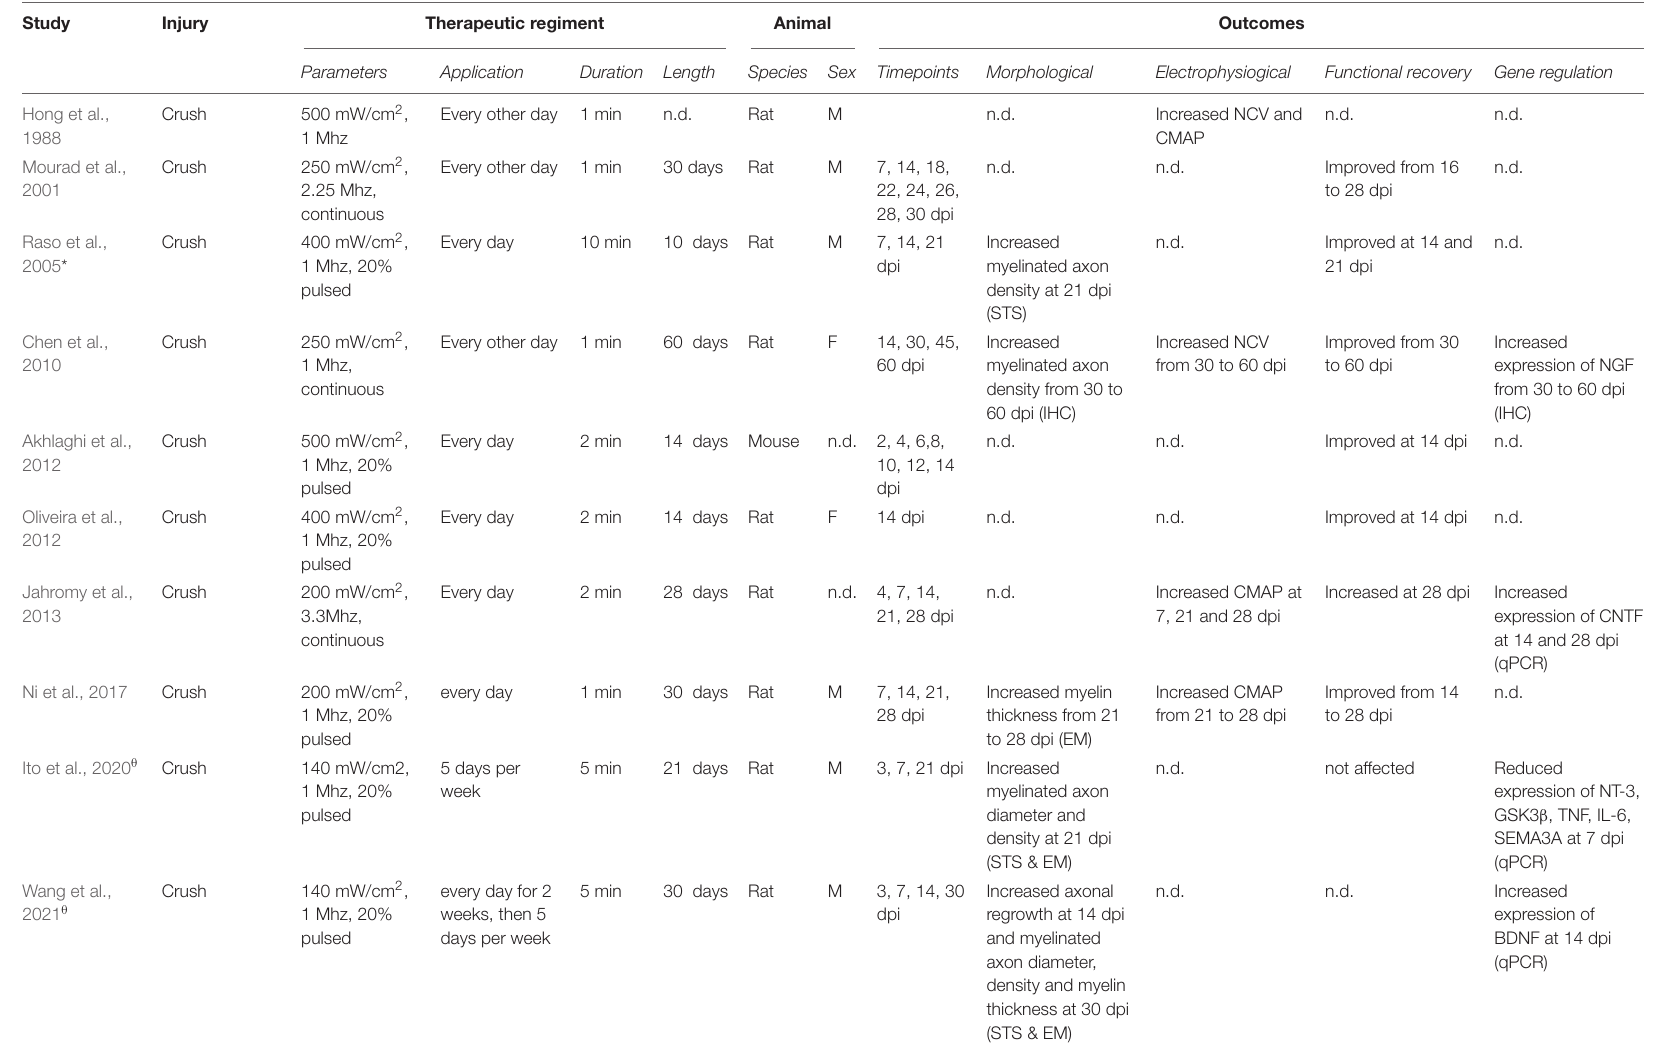
TABLE 1 | Experimental parameters and outcomes of in vivo studies investigating the role of LIU on peripheral nerve after injury.